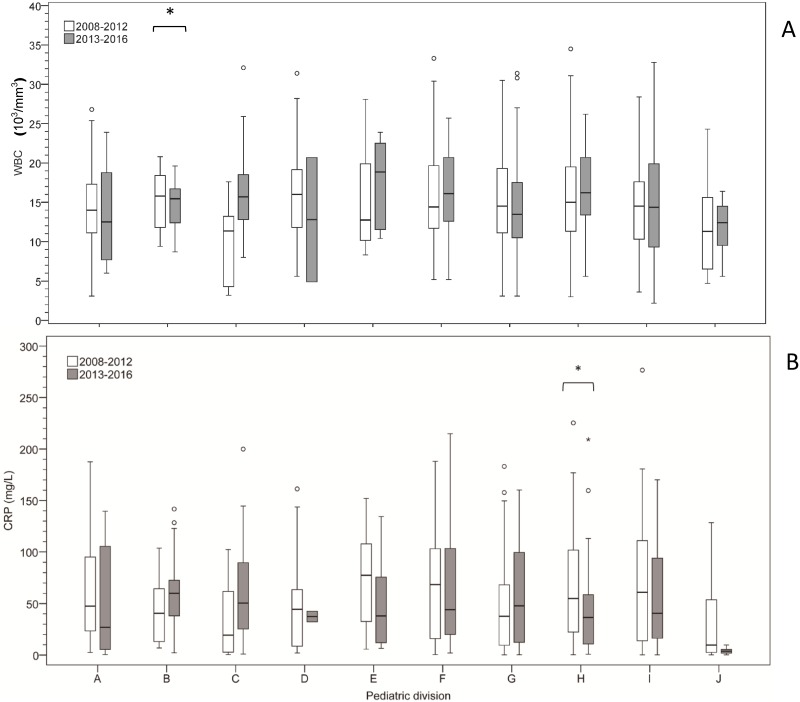
The CRP level associated with antibiotics utilization between 10 divisions of Pediatrics in two periods.